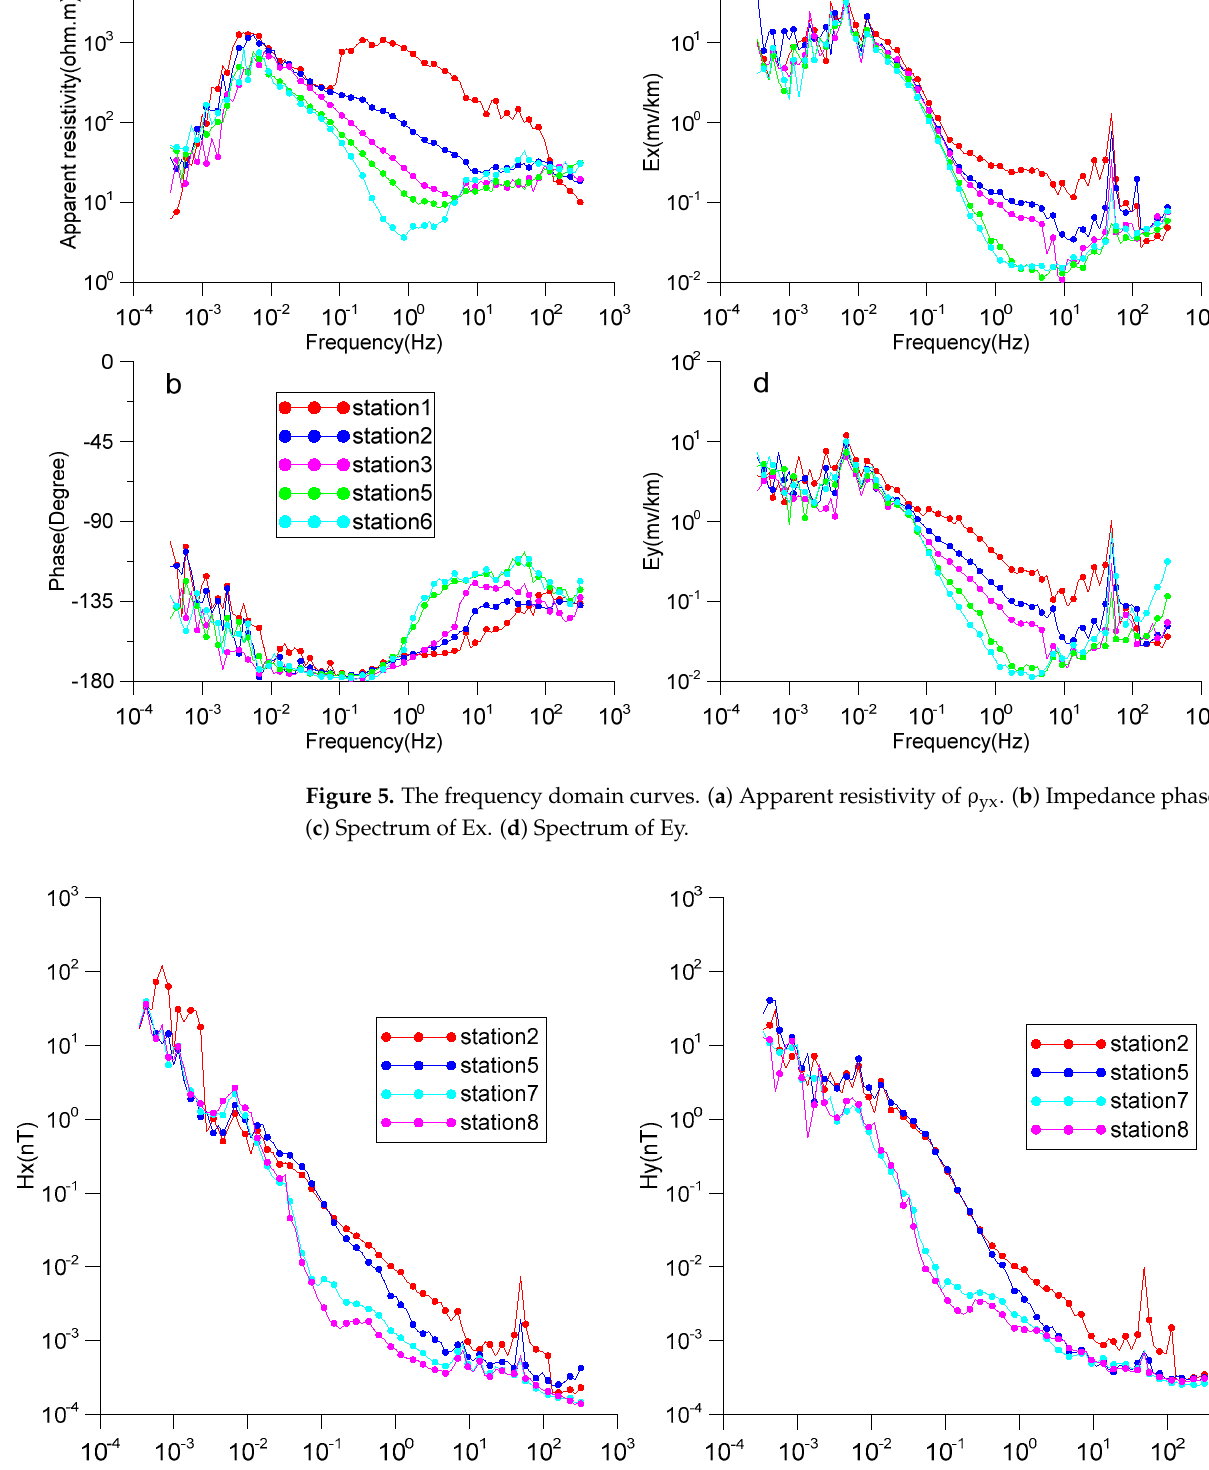
Figure 6. Amplitude of magnetic fields of some stations.